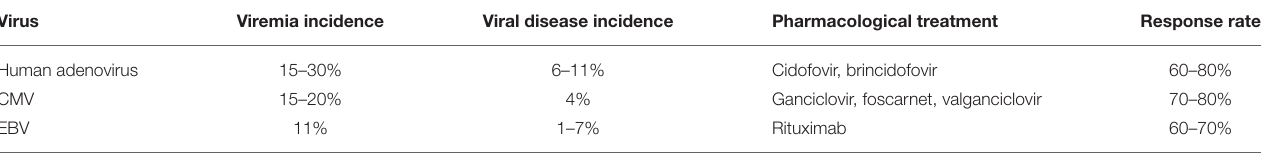
TABLE 2 | Incidence of adenovirus, CMV and EBV reactivation, disease, pharmacological treatment and rate of treatment response in children after allogeneic HSCT.